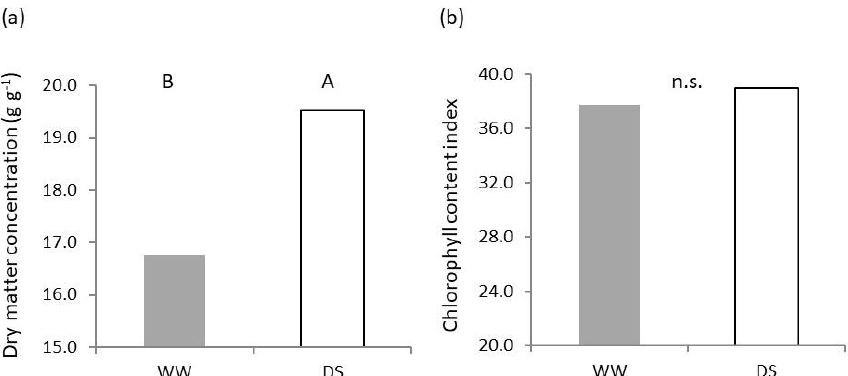
Figure 2. Effect of soil water availability on seedling shoot: ( a ) Dry matter concentration; ( b ) Chlo- rophyll concentration. Different uppercase letters designate significantly different values at the Tukey’s post hoc mean separation test for p < 0.01, or non-significant differences (n.s.) for p > 0.05.